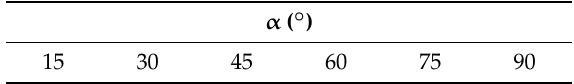
Table 1. Die semi-angles in extrusions with single-pass dies ( α ).